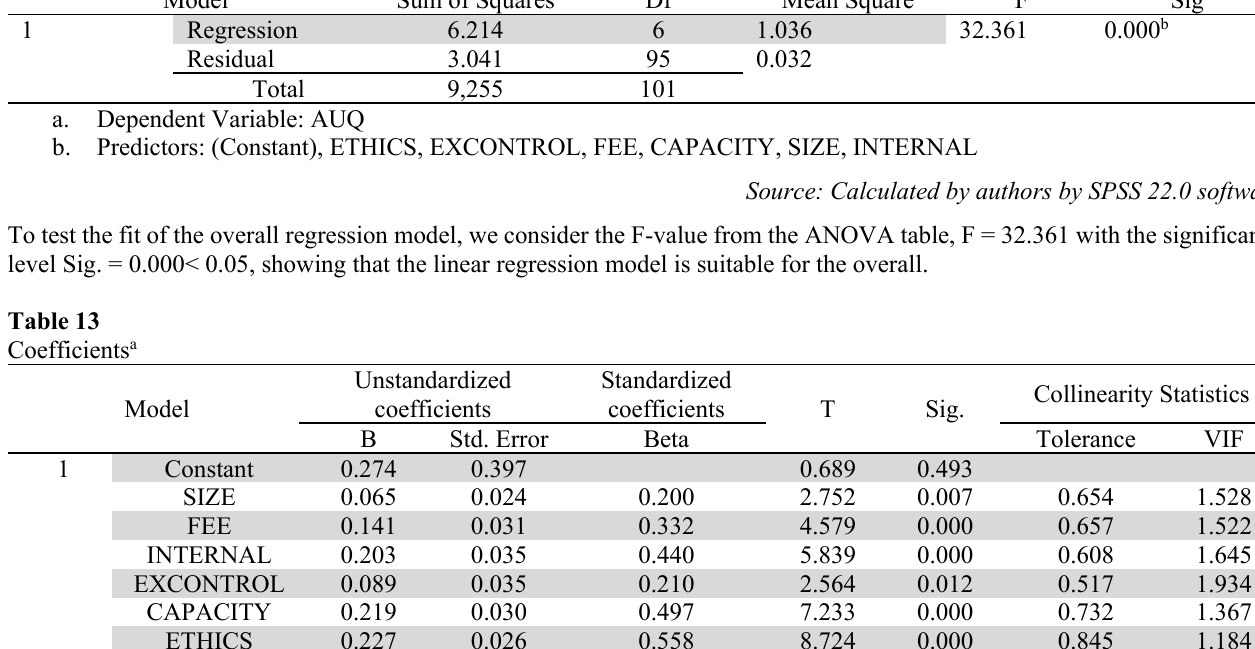
The results of testing the suitability of the regression function ( ANOVA a ) Model